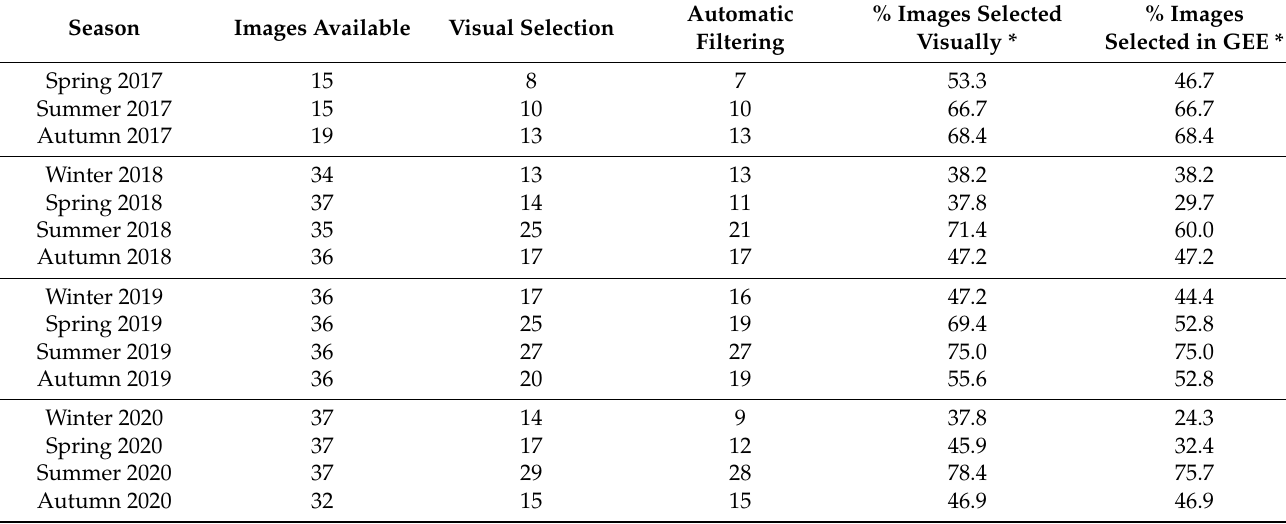
Figure 5. Workflow validation for cloud cover images. Percentage (%) of images selected in both methodologies to validate GEE script ( n : number of images available in the image collection for each year. A total of 484 images were available before cloud-cover image filtering). Table 1. Seasonal number of images used for cloud-free image filtering validation. All images available, visual selection, automatic selection in GEE and